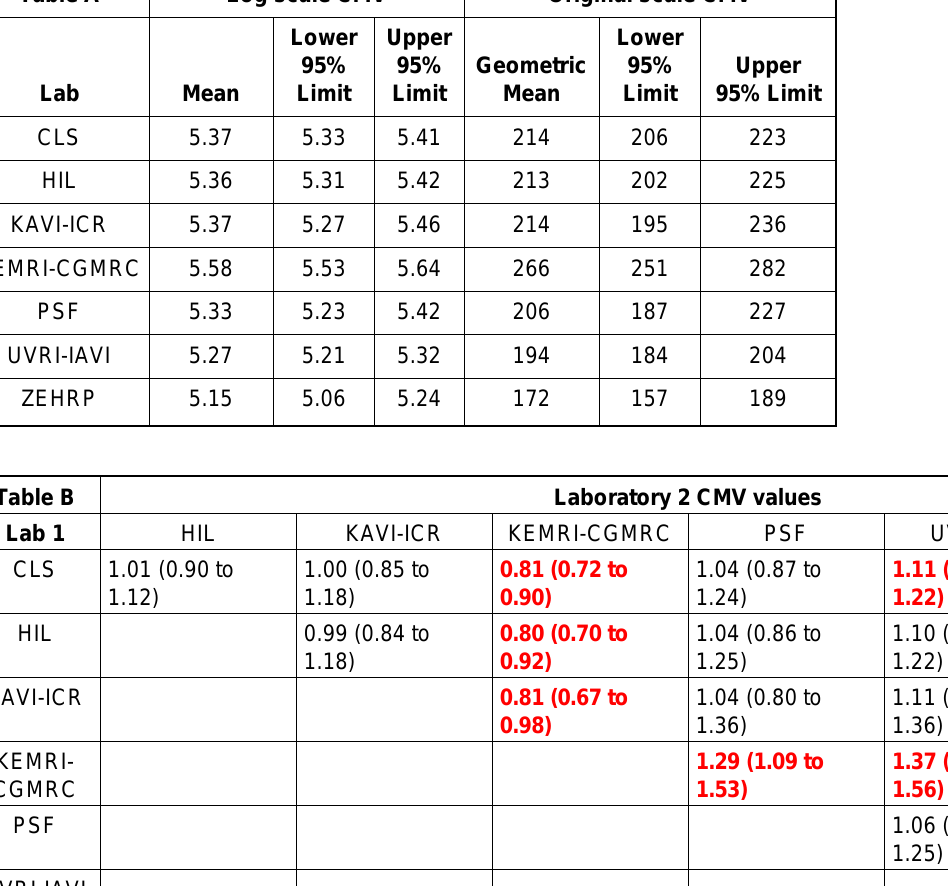
TABLE 3A, B, C-S1: Least squares mean CMV counts and differences between laboratories. S3A Table: Least squares parameter estimates and 95% confidence intervals (Bonferroni adjusted) from a repeated measures Poisson regression model of spot count on subject, site and month. S3B Table: Pairwise comparisons between sites, adjusted (Bonferroni) for multiple comparisons, from the same regression model as S3A Table. Each cell shows the difference in least squares mean log counts (Lab 1 - Lab 2) with 95% confidence intervals, exponentiated to the original scale (Overall p-values from regression model: Site = 0.012, Month = 0.49). S3C Table: Pairwise comparisons between sites, adjusted (Bonferroni) for multiple comparisons, from the same regression model as S3A Table but excluding KEMRI-CGMRC (Overall p-values from regression model: Site = 0.033, Month = 0.450).